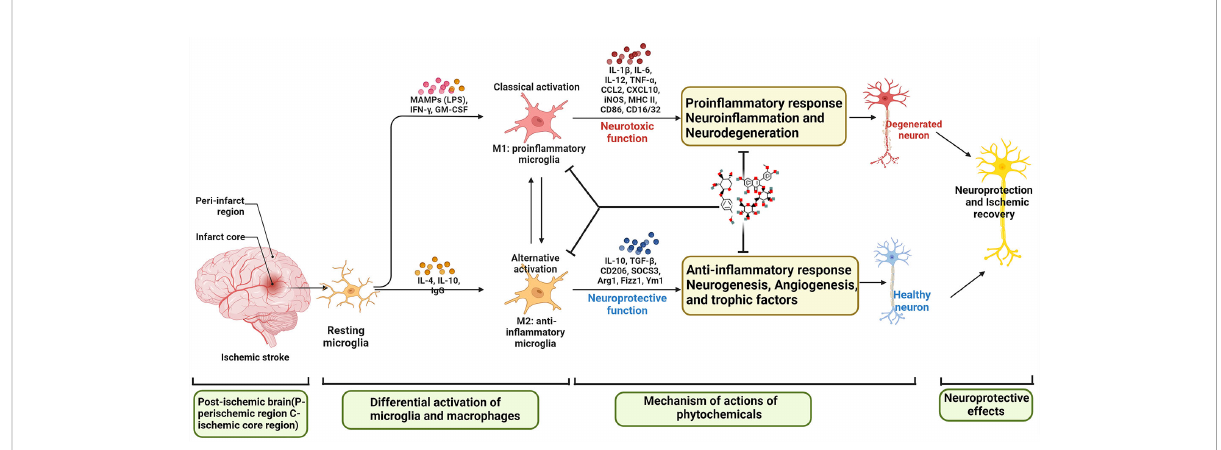
FIGURE 3 Effects of Natural botanical components on microglia/macrophages after cerebral ischemia (MAMPs, Metabolism-related molecular patterns; LPS, Lipopolysaccharide; GM-CSF, granulocyte-macrophage colony stimulating factor; IL, interleukin; TGF, transforming growth